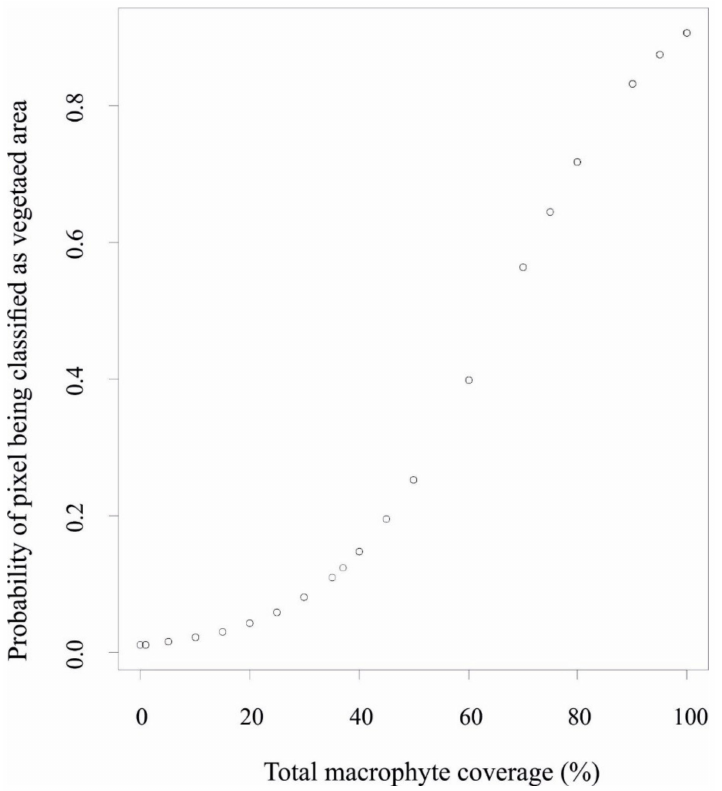
Figure 3. Logistic regression showing probabilities of pixels being classified as vegetated area along a gradient of the observed total macrophyte